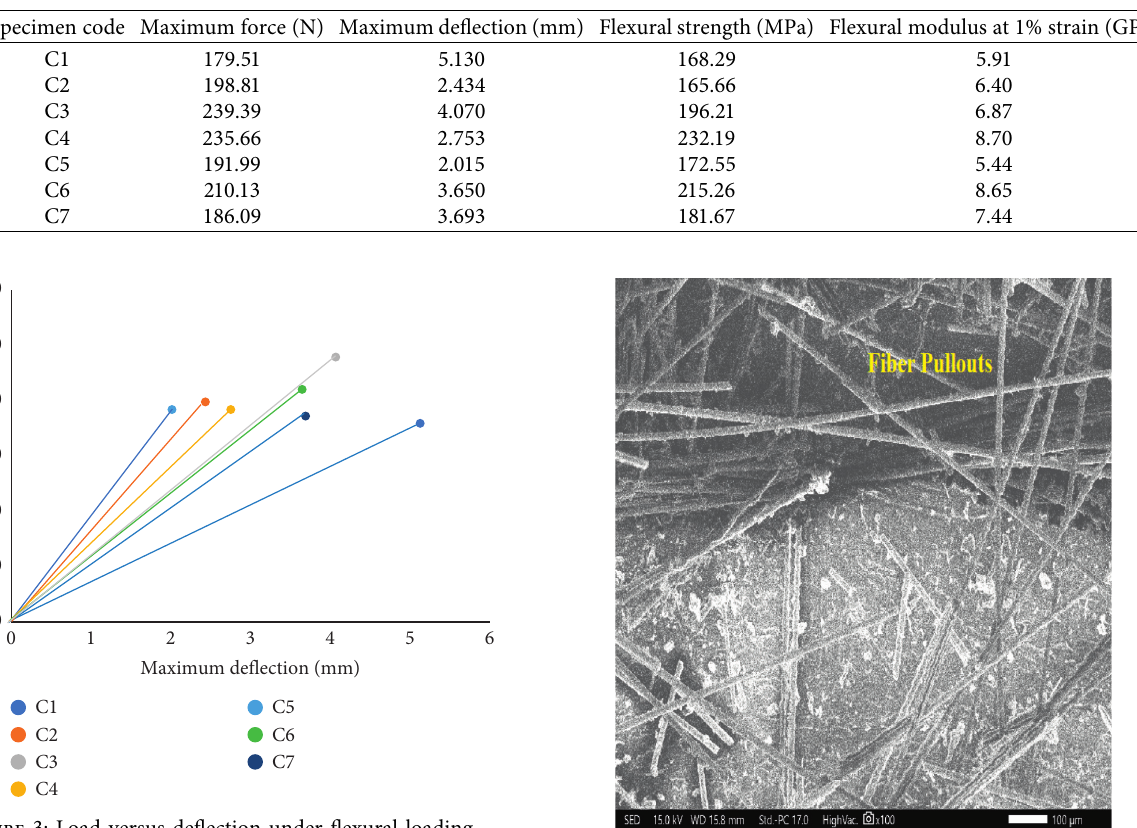
Table 2: Flexural test results.